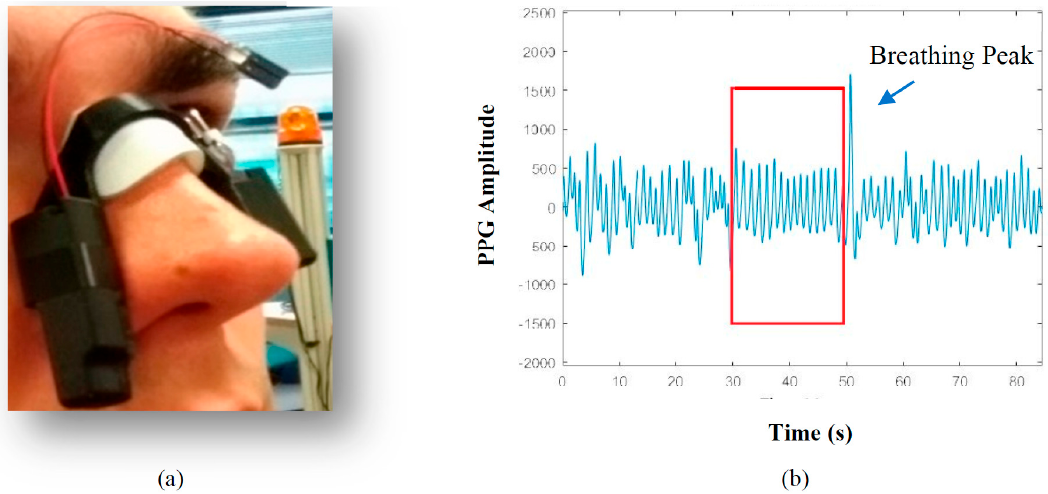
Figure 3. MORFEA positioned on the nose ( a ); generic filtered photoplethysmography (PPG) signal showing a central apnea ( b ).